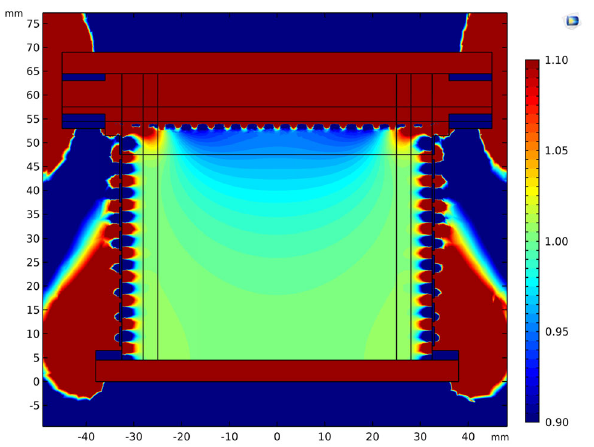
Fig. 3 Relativeelectricfieldmapwithinthecentralcrosssectionofthe TPC for the reference voltage configuration: + 5211V (anode), + 86V (first ring) and − 744V (cathode). The colour scale is set to ± 10% relative to (cid:5) E d (cid:6) = 183 V/cm. Figure made with COMSOL ®